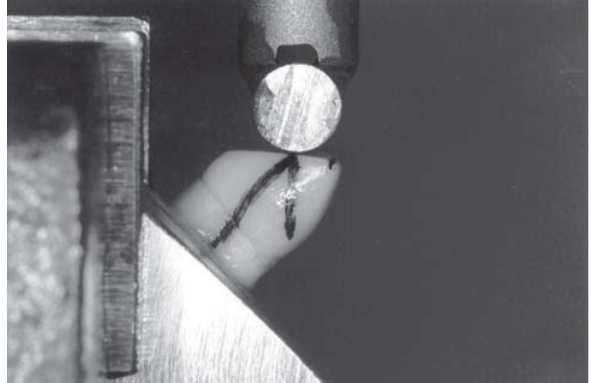
FIGURE 5- Specimen mounted in a universal testing machine for static loading test. Load was applied 45 0 with the tooth long axis, in one point of the crown surface